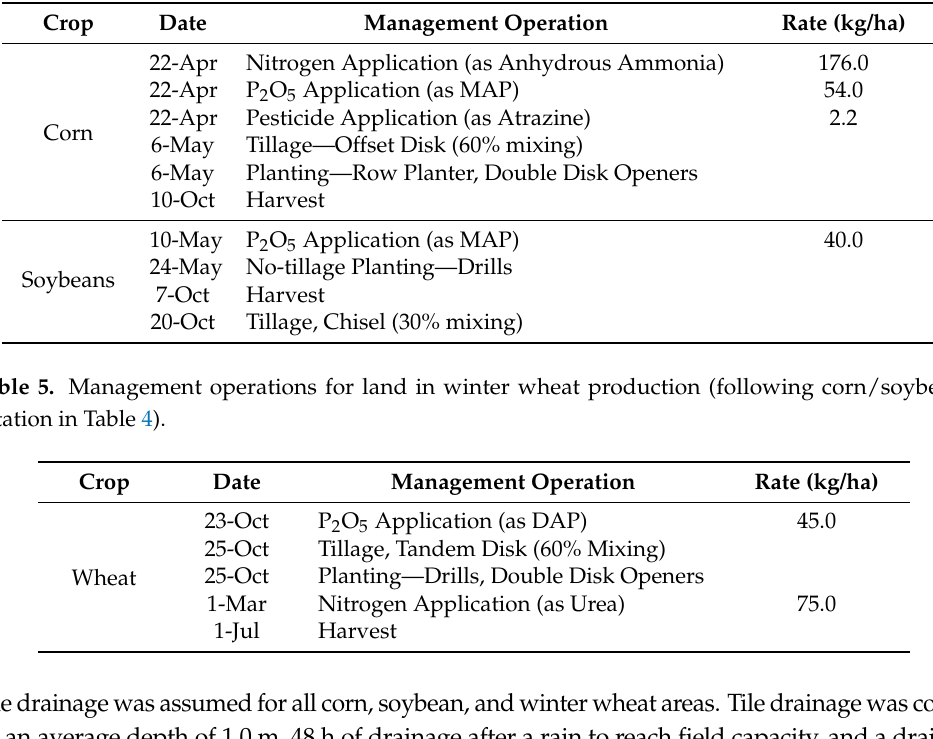
Table 4. Management operations for land in corn/soybeans rotation.